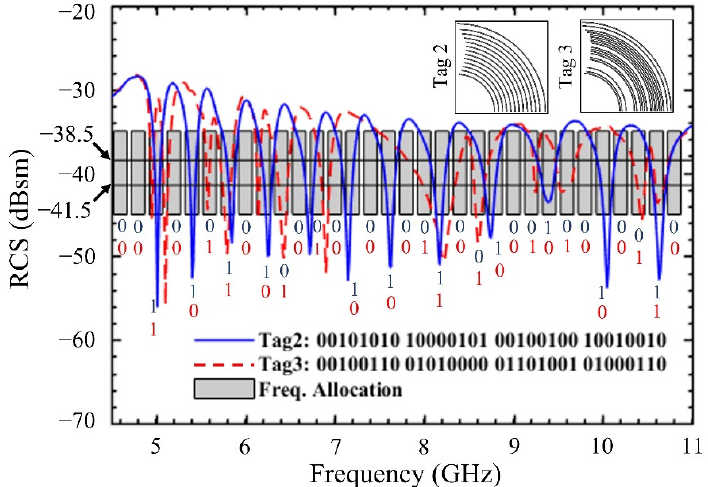
Figure 5. Simulated RCS response of CRFID tag instances: Tag 2, Tag 3. (Inset shows corresponding tag geometry). Table 4. Comparison with state-of-the-art CRFID tags. Ref.